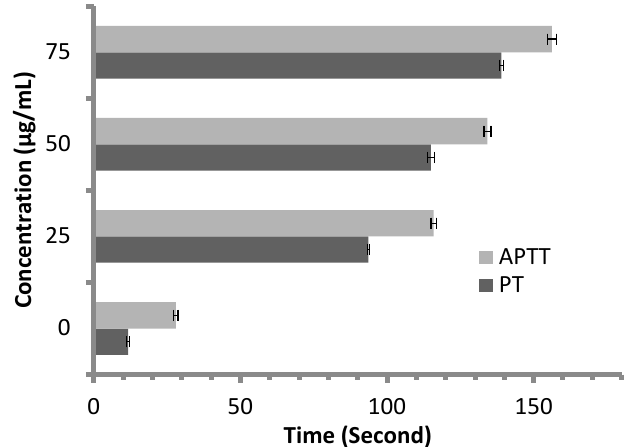
Figure 9. Anticoagulant activity of heparin at different concentrations, represented by PT and APTT.